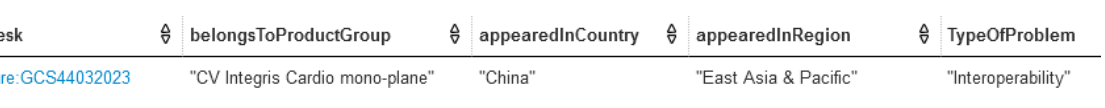
Figure 13. A snippet of the JAPE file “Issue.jape”.